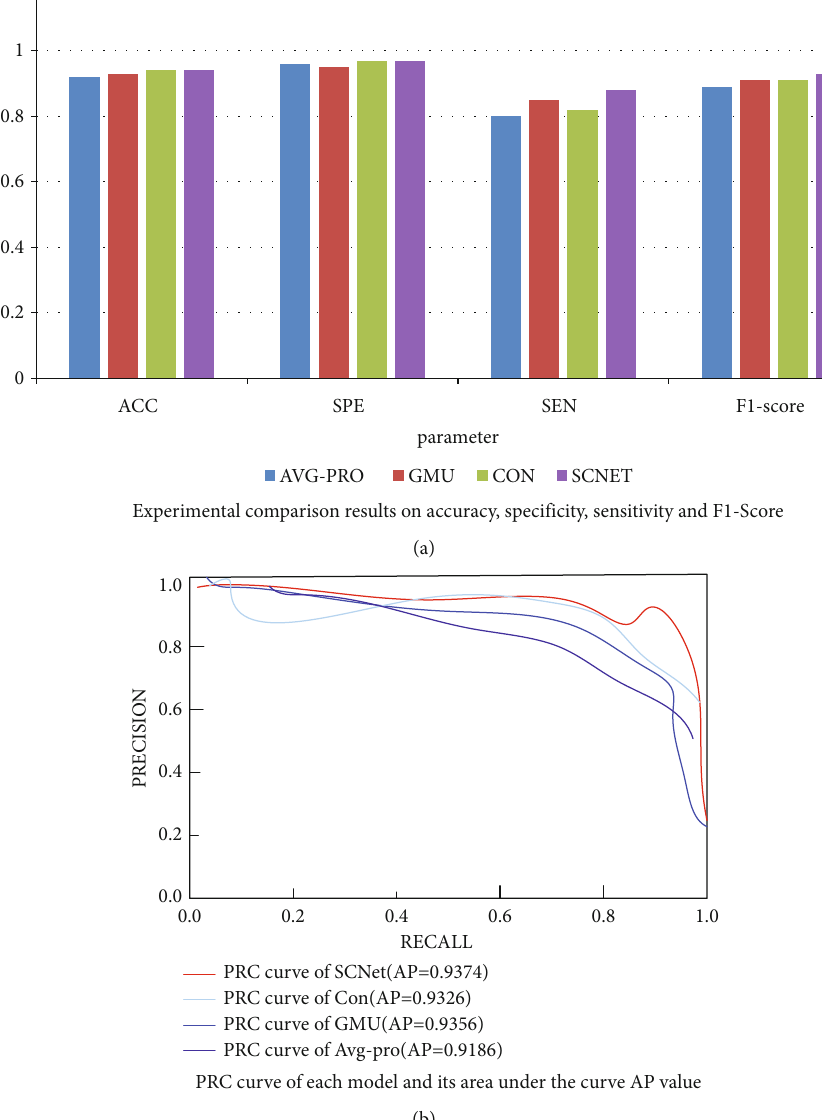
Figure 10: Comparison of SCNet and multimodal benchmark model